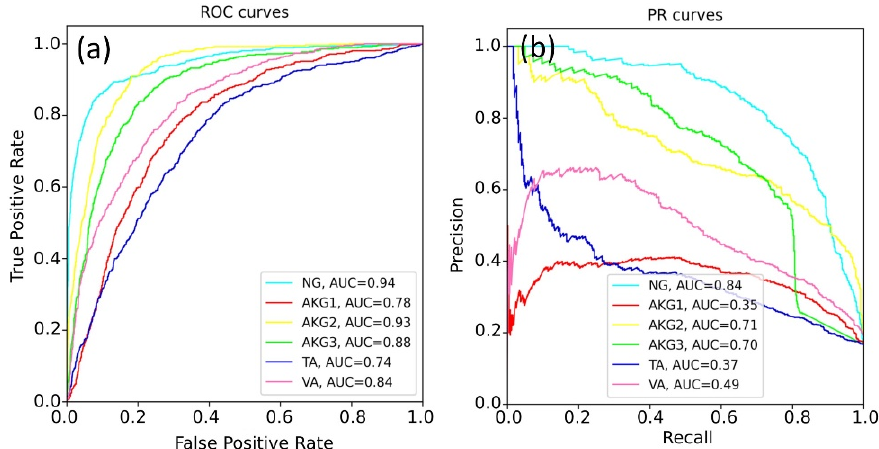
Figure 6. The quality of EfficientNet-B4 prediction for all classes: ( a ) the ROC-AUC metric and ( b ) the PR-AUC metric.